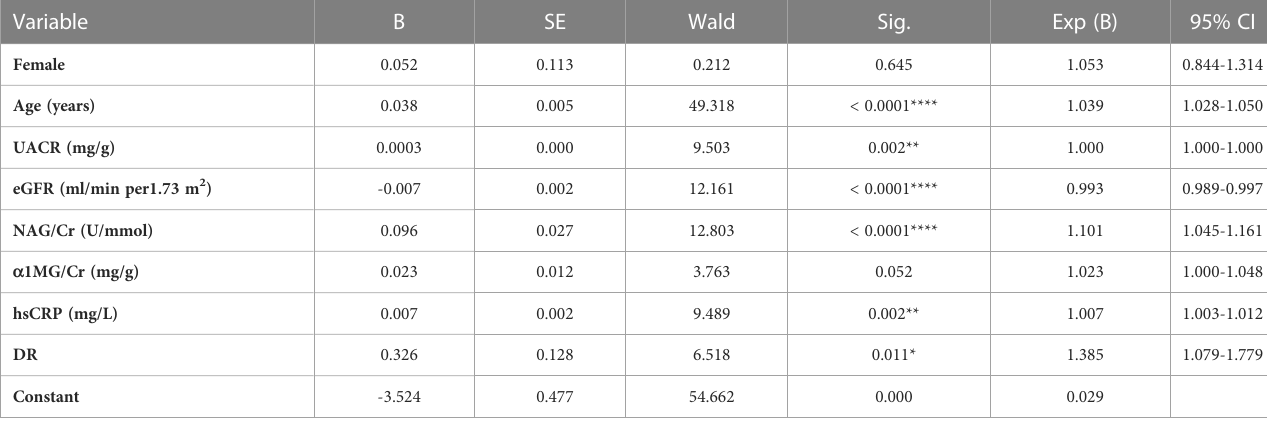
TABLE 3 Logistic analysis of anemia and clinical characteristics of diabetic patients.